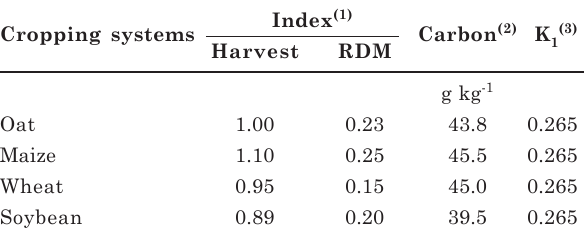
(1) Index obtained based on results associated with maize cultivation: index values of 1.10 and 0.25 for maize cultivation indicate that 1 Mg of grain yields the equivalent of 1.1 Mg of shoot dry matter and 0.25 Mg for root dry matter; (2) Determined by dry combustion; (3) As proposed by Sá et al. (2001), K represents the C coefficient of